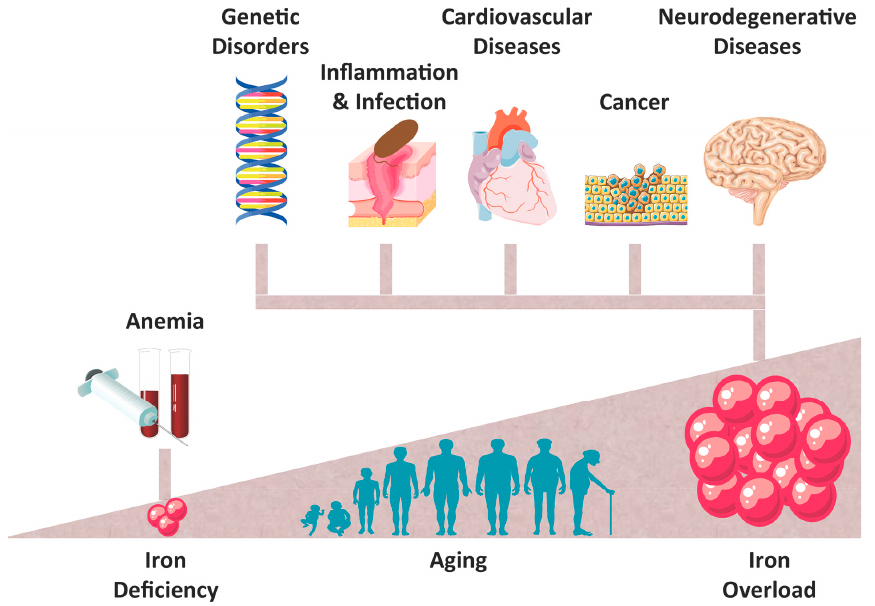
Figure 1. The importance of Iron in pathophysiologic conditions. Essential to ensure survival, disruption of iron homeostasis has been shown to be involved in a variety of pathophysiological conditions, which include anemia and iron-overload related disorders. In particular, the importance of tissue iron accumulation in inflammation and infection, cancer, genetic, cardiovascular and neurodegenerative diseases continuously increases.